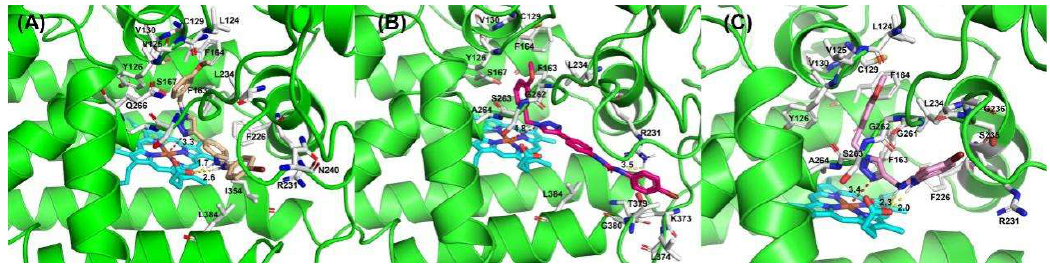
Figure 4. The binding modes of compounds 3a ( A ), 5e ( B ) and 7f ( C ).